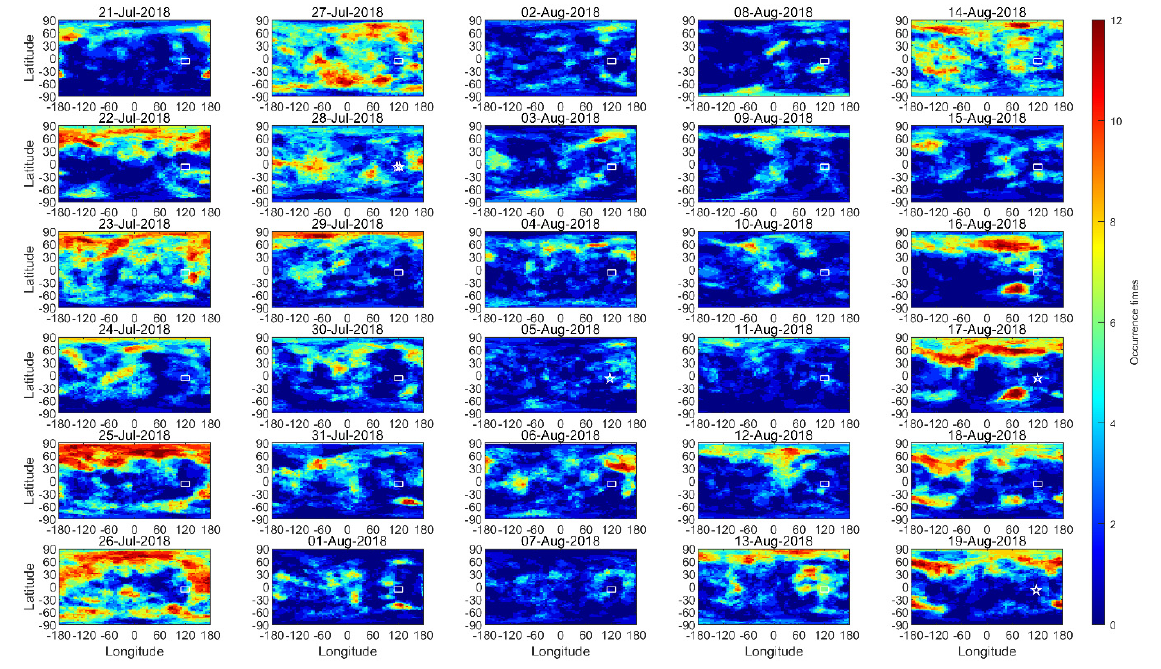
Figure 15. Daily occurrence times of the TEC decrease anomaly from JPL. The time resolution of JPL GIM is 2 h. The UT date is noted on top of each panel. The white box denotes Region A, and the stars denote the earthquakes occurring on the four days.